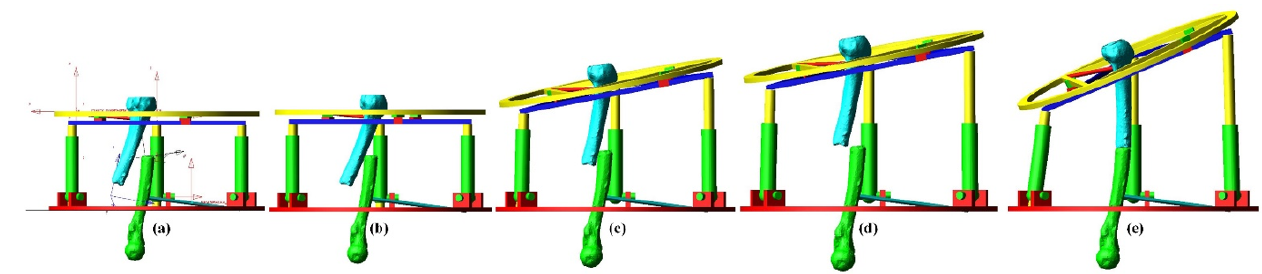
Figure 15. Adams view of the mechanism configuration for each step of the bone reduction trajectory in xz plane view (a–e)